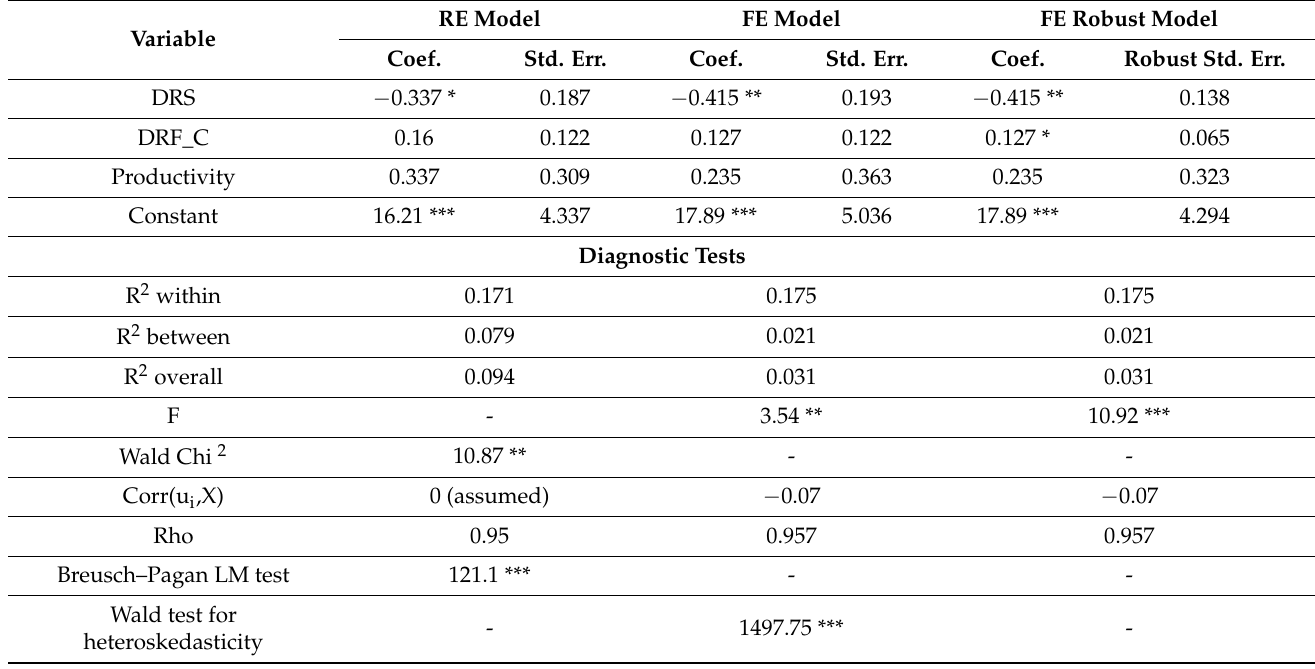
Table 3. Regression results—FNTREZEXPL dependent (Equation